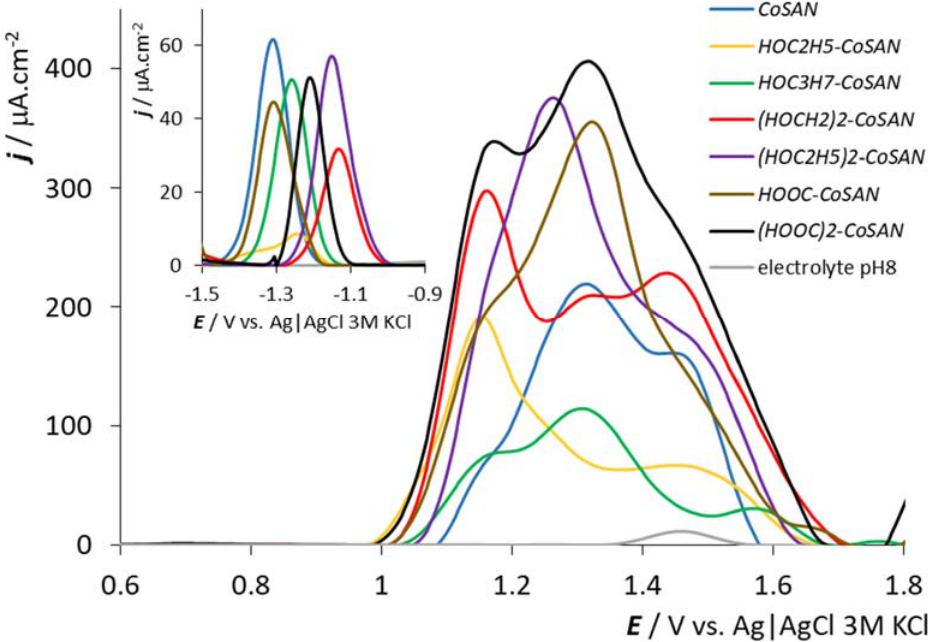
Figure 2. DPV of all used compounds, PB, pH = 8, 500 µ M concentrations of all samples, GCE. See caption in the panel for sample identification.